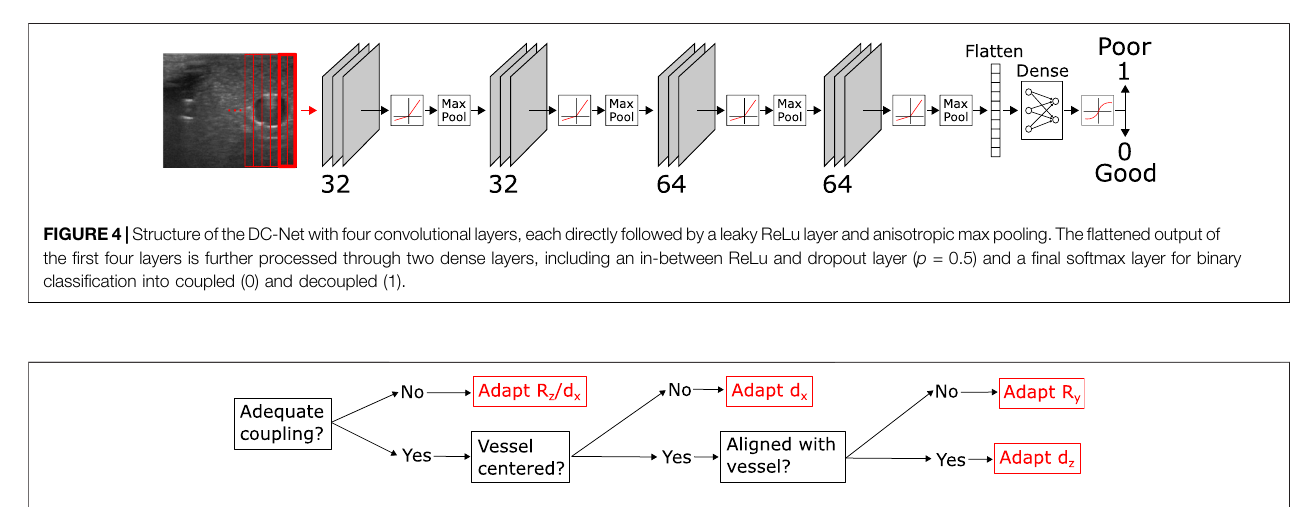
FIGURE5 | Outline ofthe hierarchical planningroutine, employing different tracks for adapting theprobe orientationand position with respect tothe tissue surface or the reconstructed anatomy. We prioritise in the order of coupling over the centering of the vessel and fi nally the alignment of the vessel center line.